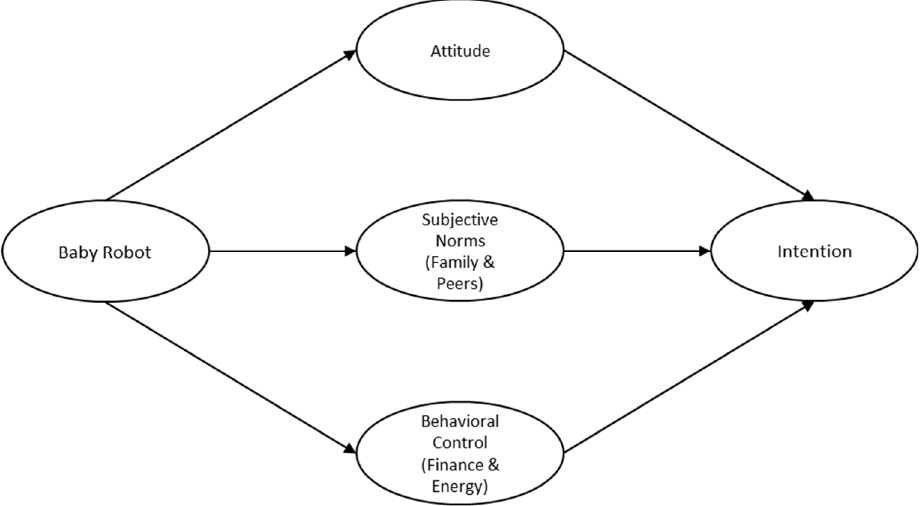
Figure 1. The theoretical model of the current study.